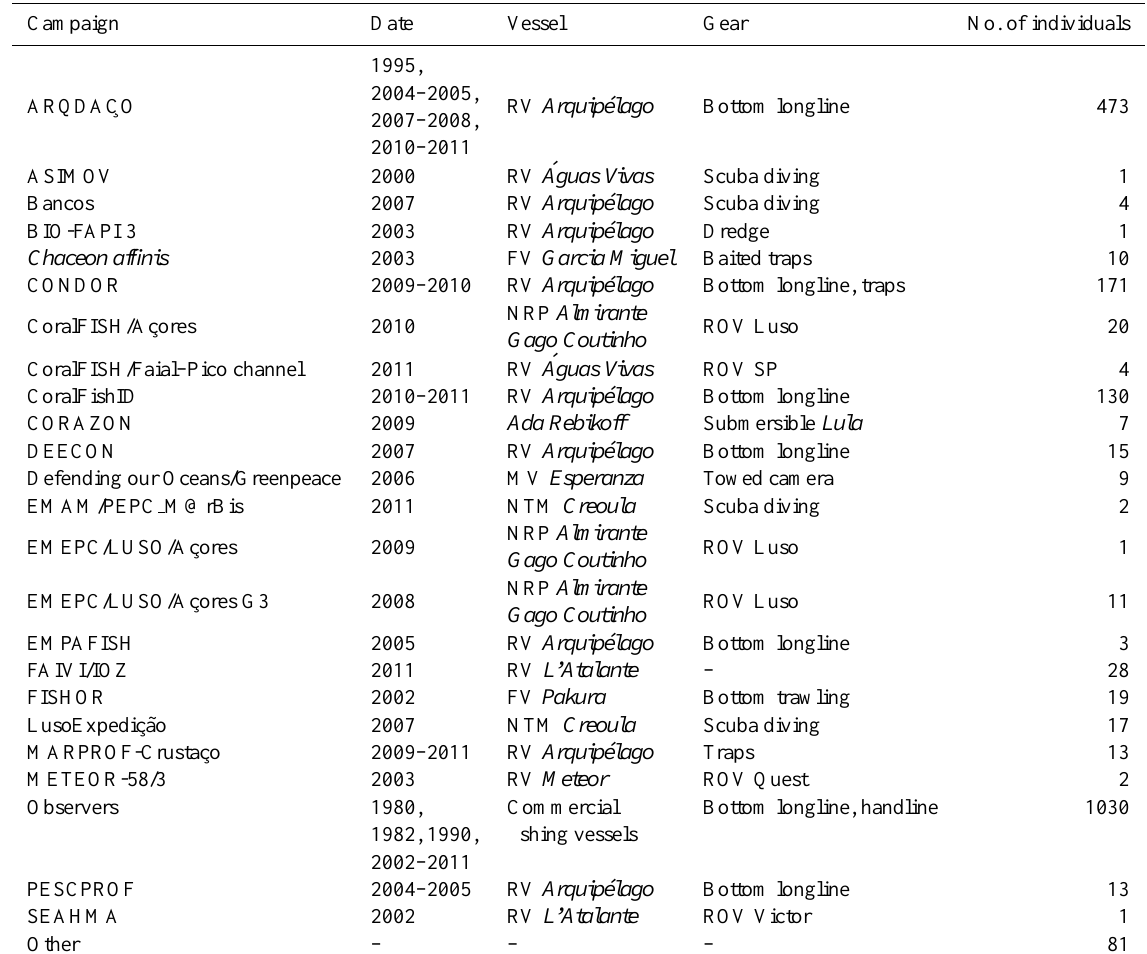
Table 2. Source details for coral IMAR-DOP/UAc records collected in the Azores EEZ.